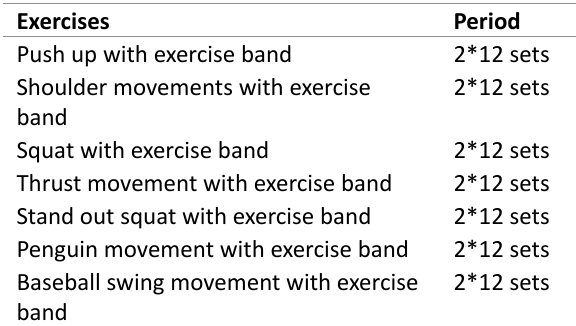
Table 1. Types of exercise, duration and shape